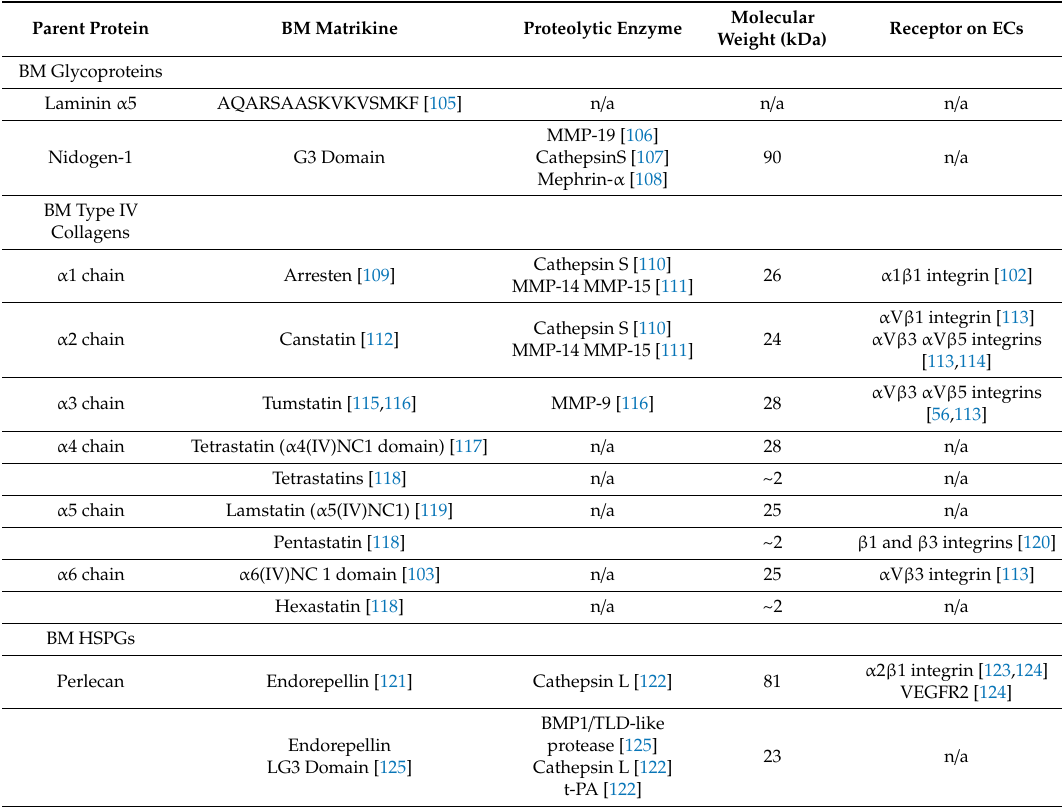
Table 2. BM components and their corresponding